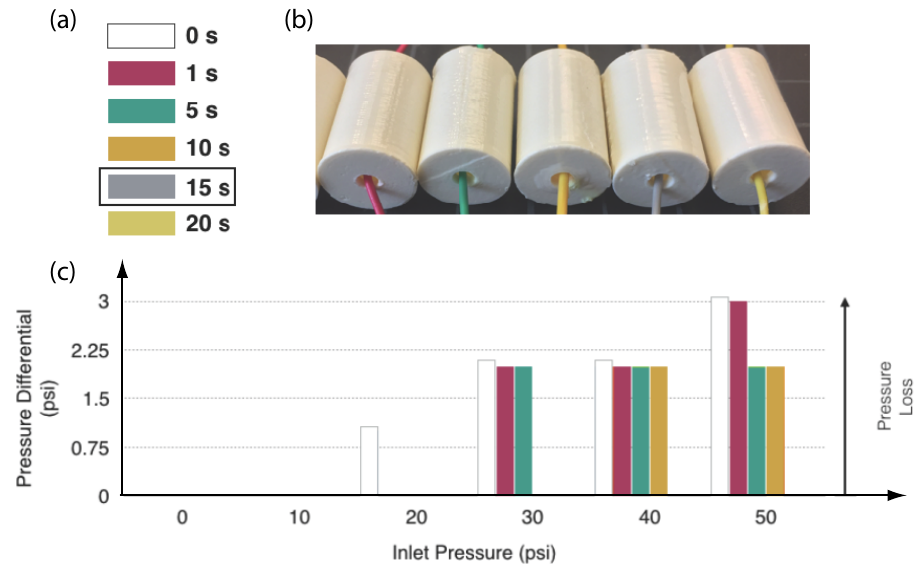
Figure 5. ( a ) Experimental times chosen to determine optimum acetone dip time, ( b ) cylinders (color coded) after acetone treatment, and ( c ) pressure loss for different inlet pressure for each of the